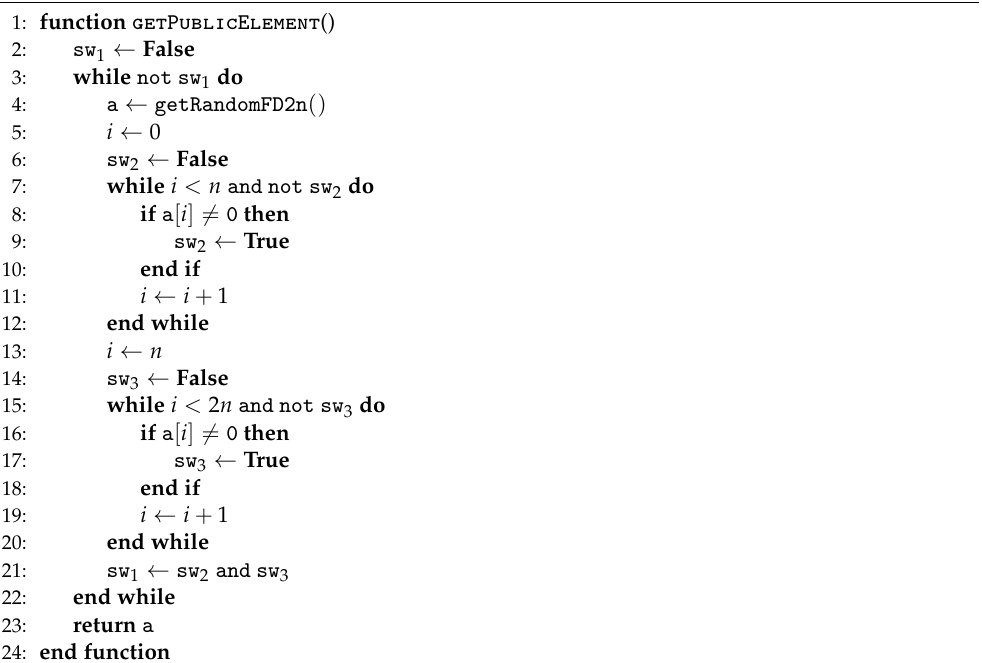
Algorithm 19 Computes a random public element h